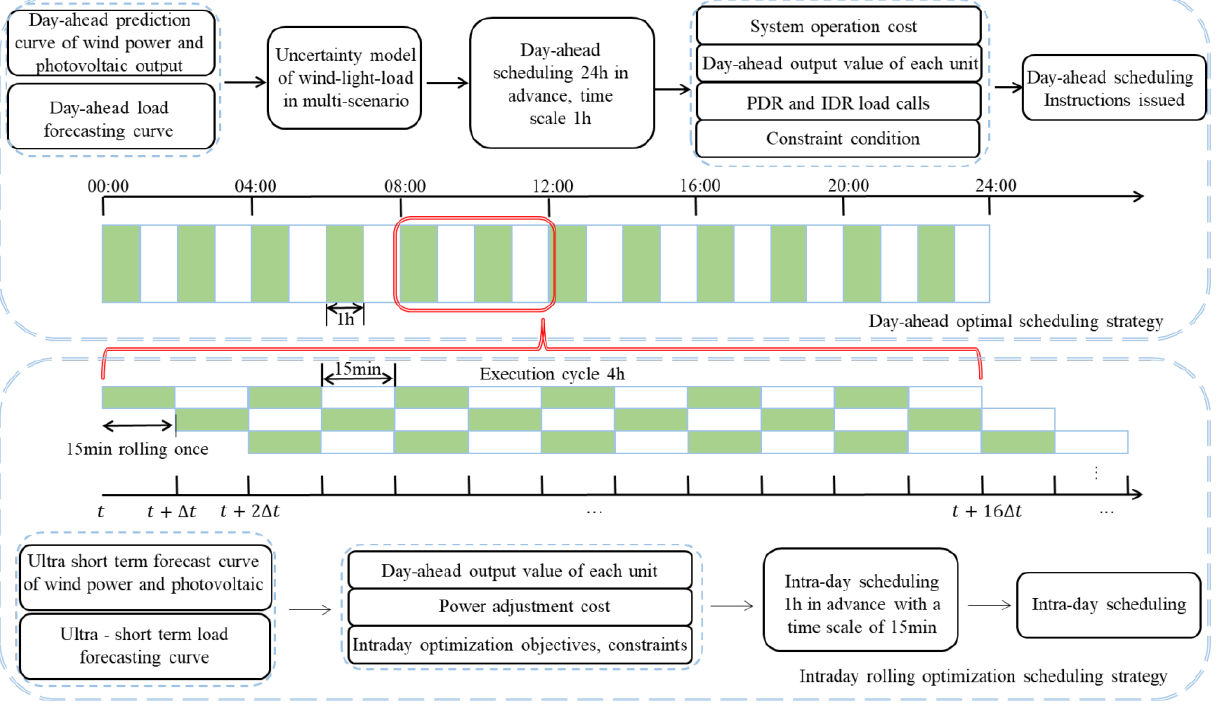
Figure 3. Diagram of the multi-source complementary power generating system ’ s optimal scheduling method.